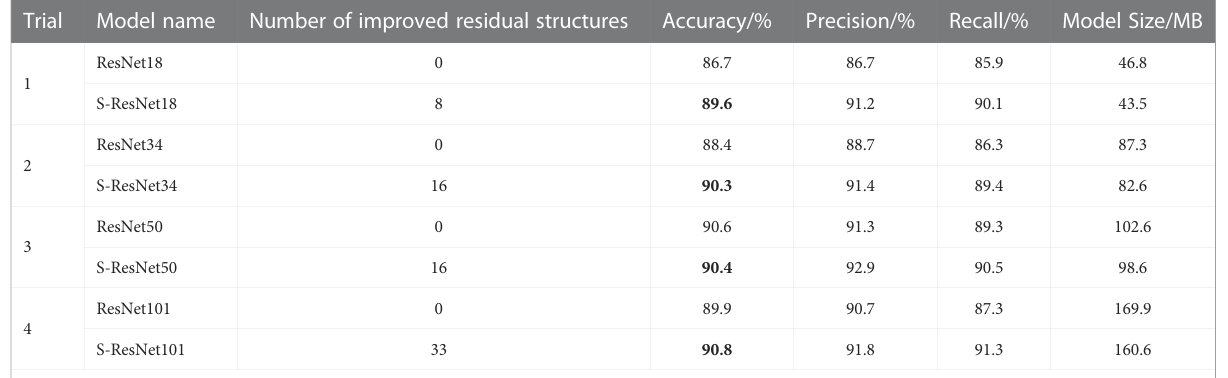
TABLE 4 Impact of improved residual structure on network